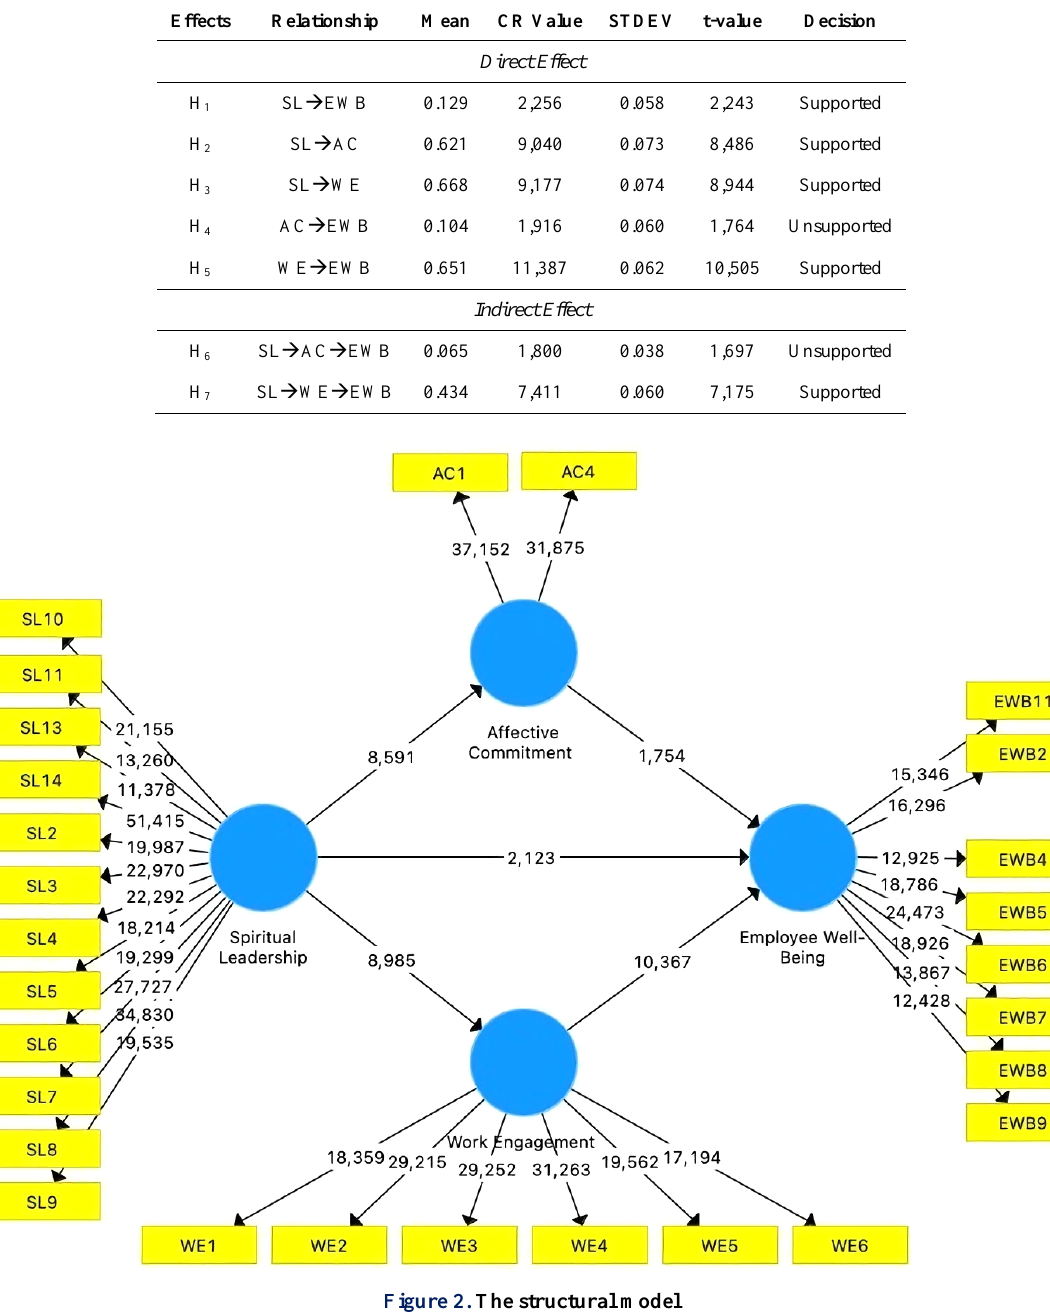
Table 5. Results of hypothesis testing